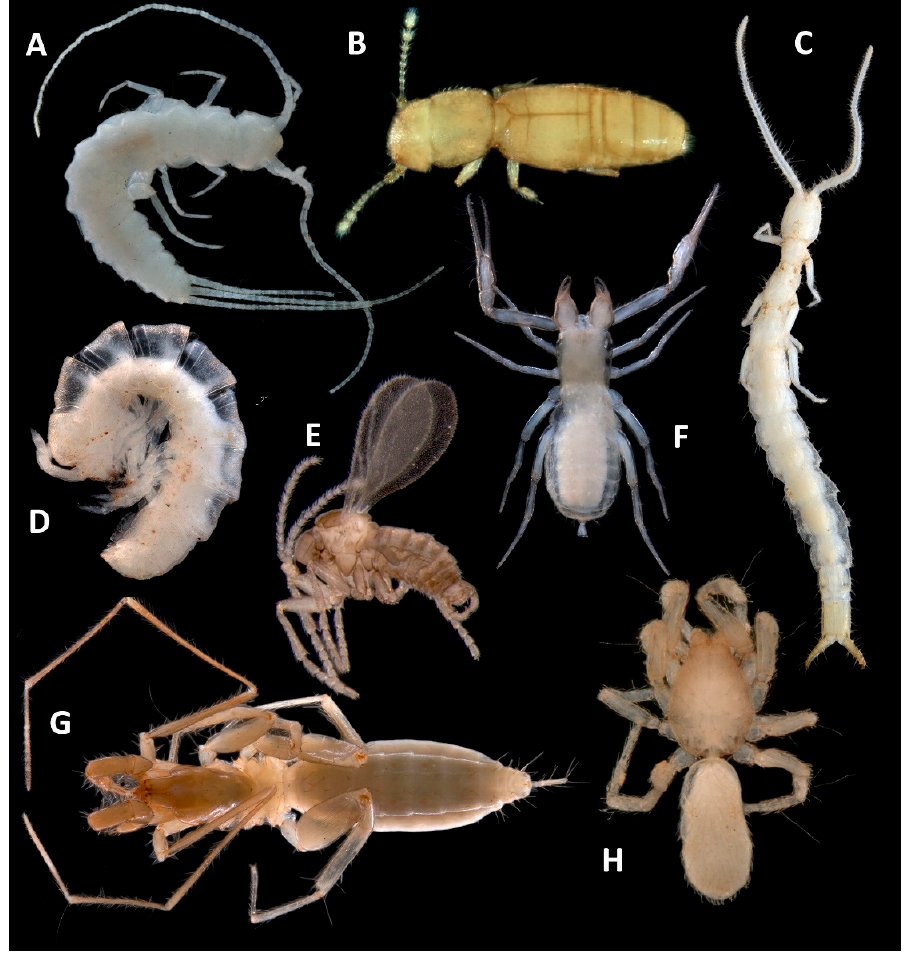
Figure 4. Troglofauna at the mesas. ( A ) Trinemura ‘MesaA1’; ( B ) Ptinella sp. B01; ( C ) Japygidae sp.; ( D ) Troglarmadillo ‘Helix-ISA005’; ( E ) Allopnyxia sp. B01; ( F ) Tyrannochthonius aridus ; ( G ) Draculoides sp.; ( H ) Prethopalpus scanloni . Photos by Jane McRae.